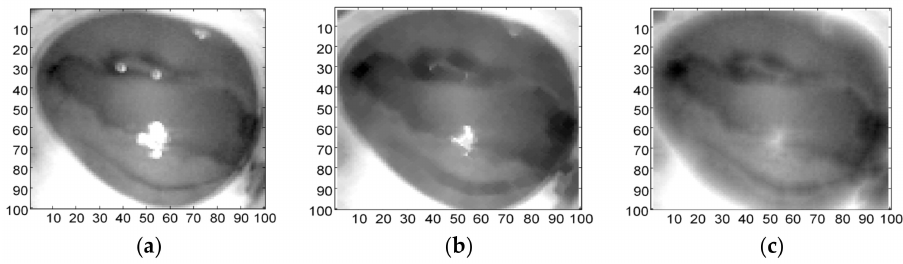
Figure 4. Eroded Image. ( a ) Original image; ( b ) Eroded with ‘disk’ SE; ( c ) Eroded with ‘spherical’